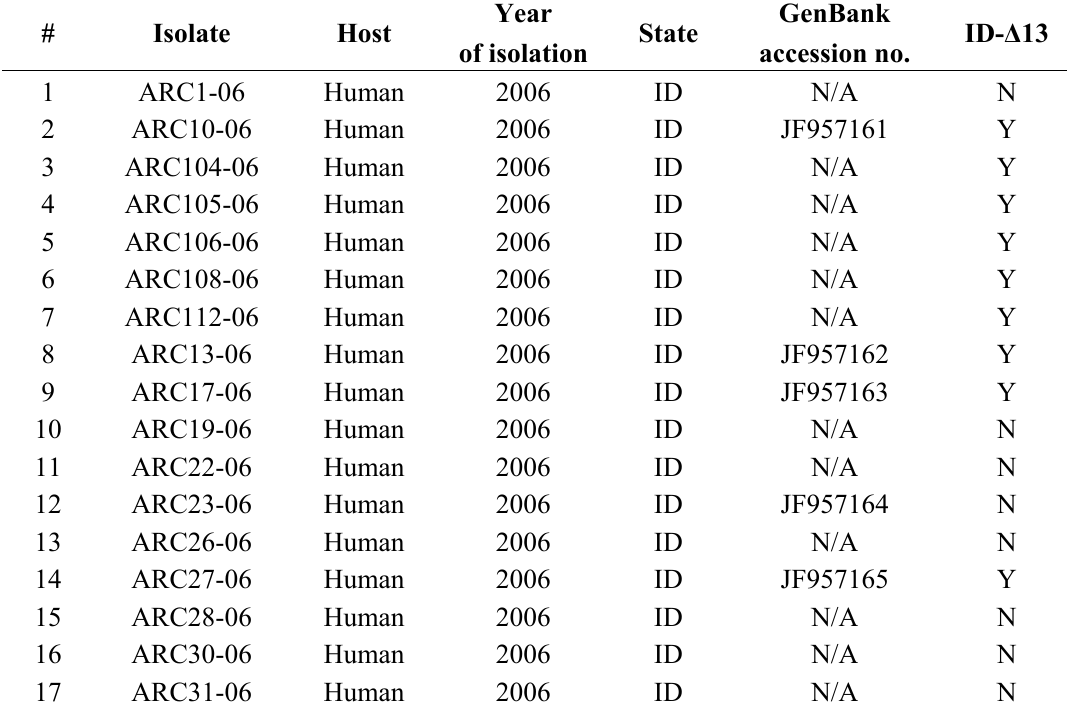
Table 1. List of WNV isolates and presence of ID- Δ 13 detected by RT-PCR. Y = ID- Δ 13 deletion present, N = ID- Δ 13 deletion